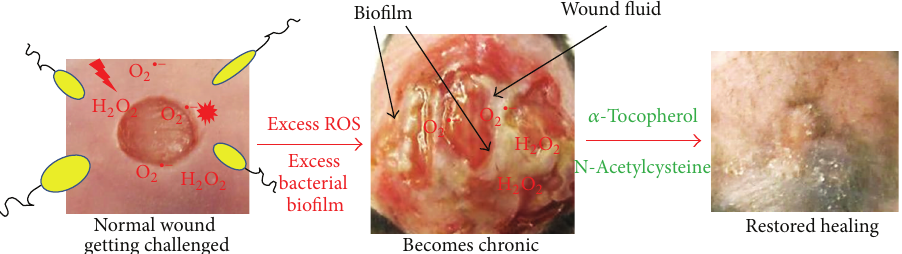
Figure 9: Schematic illustration of our chronic wound development model and how chronicity is reversed. A wound is created in the presence of excessive levels of reactive oxygen species by inhibiting key antioxidant enzyme (IAE) activity. These wounds become chronic and produce wound exudate that contains bacterial biofilms. Reversal of chronicity towards normal healing was achieved by application of antioxidant agents (AOA) 𝛼 -toc and N-acetyl cysteine (NAC).